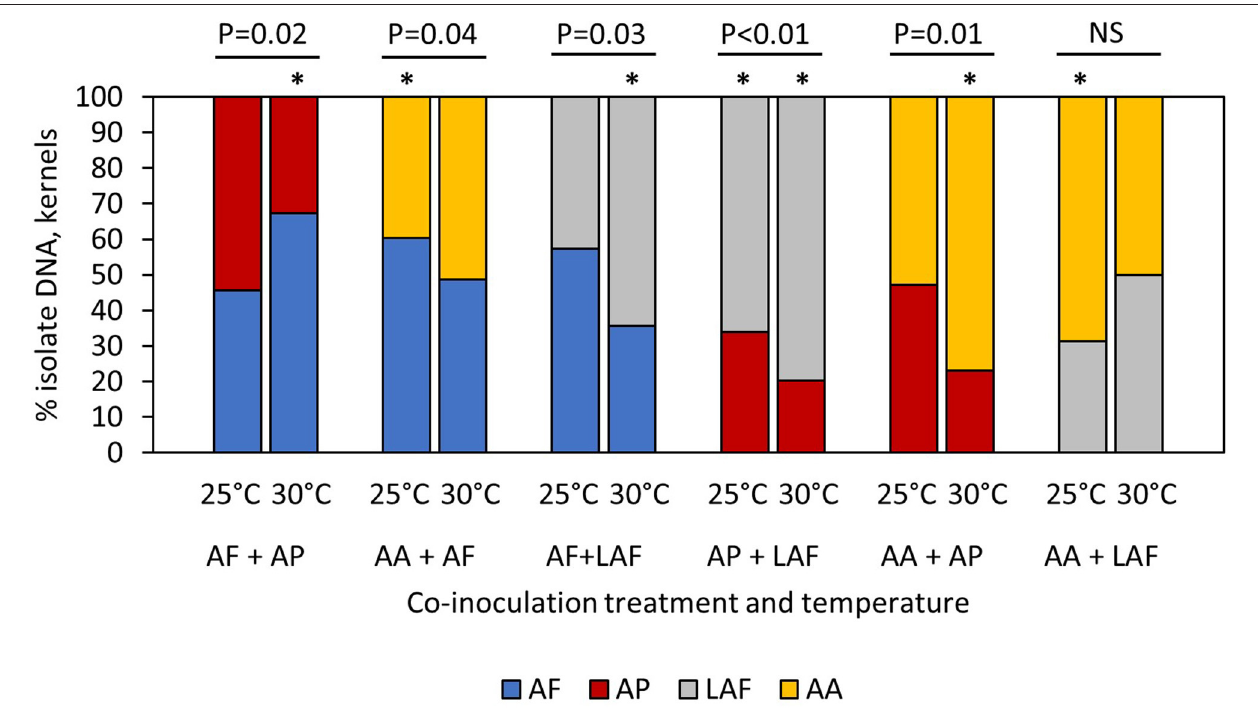
FIGURE 1 | Influence of temperature on competition between co-inoculated Aspergillus isolates during maize kernel colonization. AF, A. flavus L strain (AF13) (L-type); AP, A. parasiticus (AP2999) (L-type); AA, A. aflatoxiformans (BN008-R) (S-type); LAF, Lethal Aflatoxicosis Fungus (K0550K) (S-type). Asterisks above individual bars indicate treatments with percentages that are significantly different than 50% ( t -test, P < 0.05). P values above the groups of paired bars indicate outcomes of competition were significantly different at 25 and 30 ◦ C ( t -test, P < 0.05). NS indicate not significant. isolate “N” grown individually, %M m = % isolate “M” in mycelia, %N m = % isolate “N” in